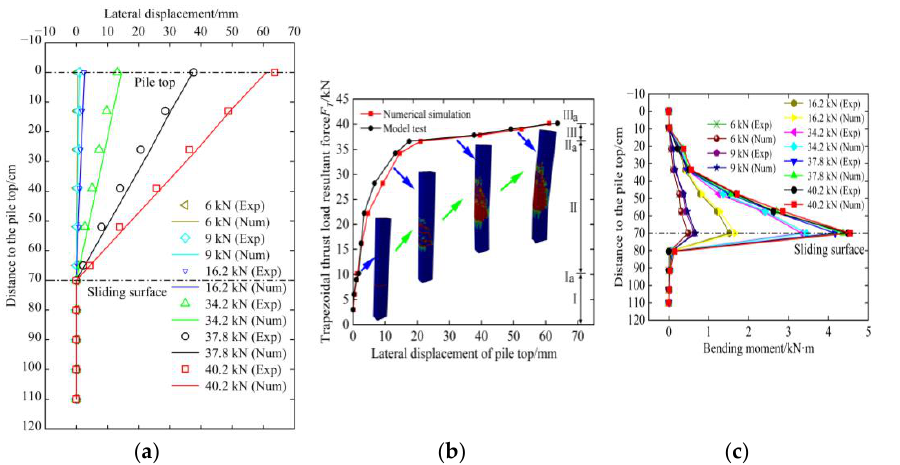
Figure 23. Comparison of the experimental and numerical simulation results. ( a ) Displacement; ( b ) thrust load-pile top displacement; ( c ) distribution of bending moment.